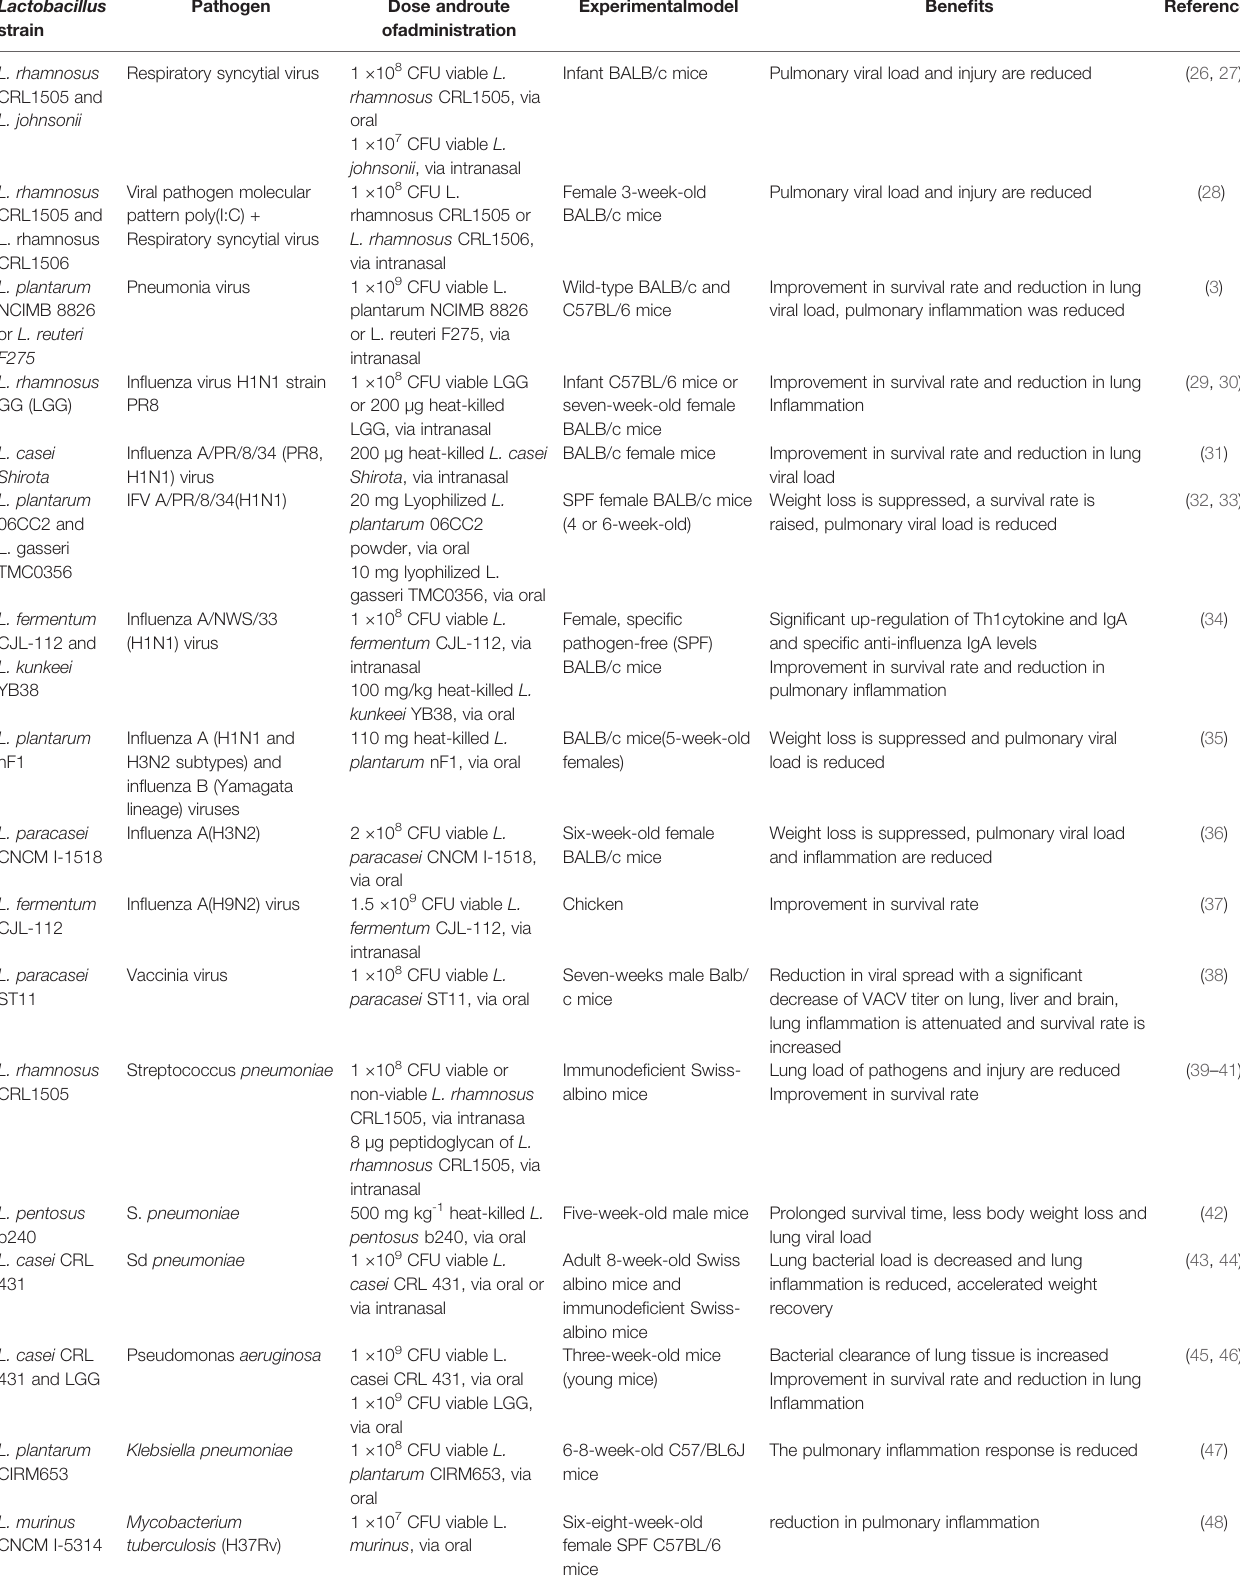
TABLE 1 | Pre-clinical studies on the administration of the Lactobacillus for protection against bacterial and viral respiratory tract infections. Lactobacillus